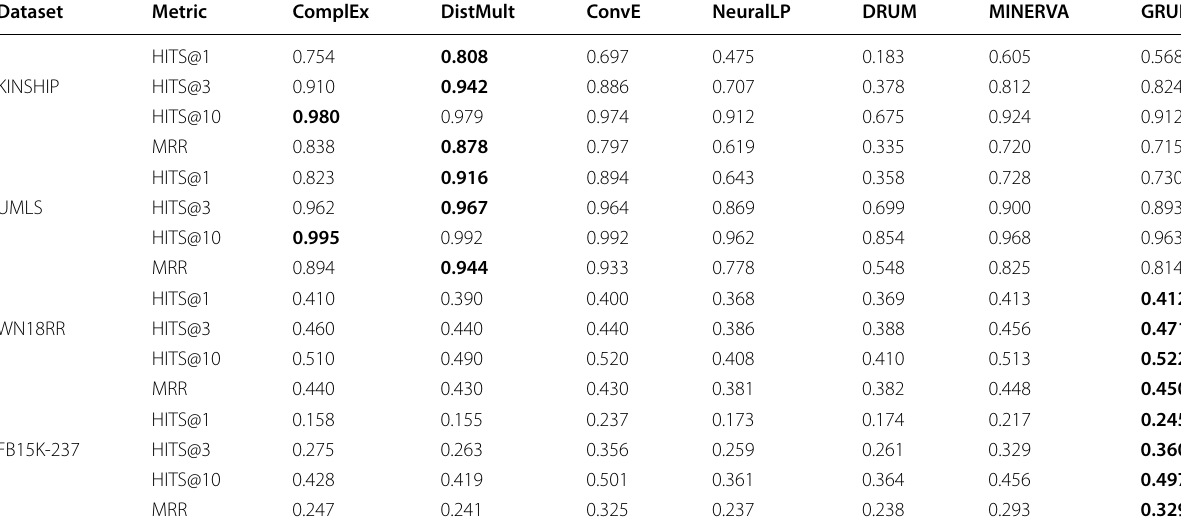
Bold numbers are the results obtained by the best method in the table